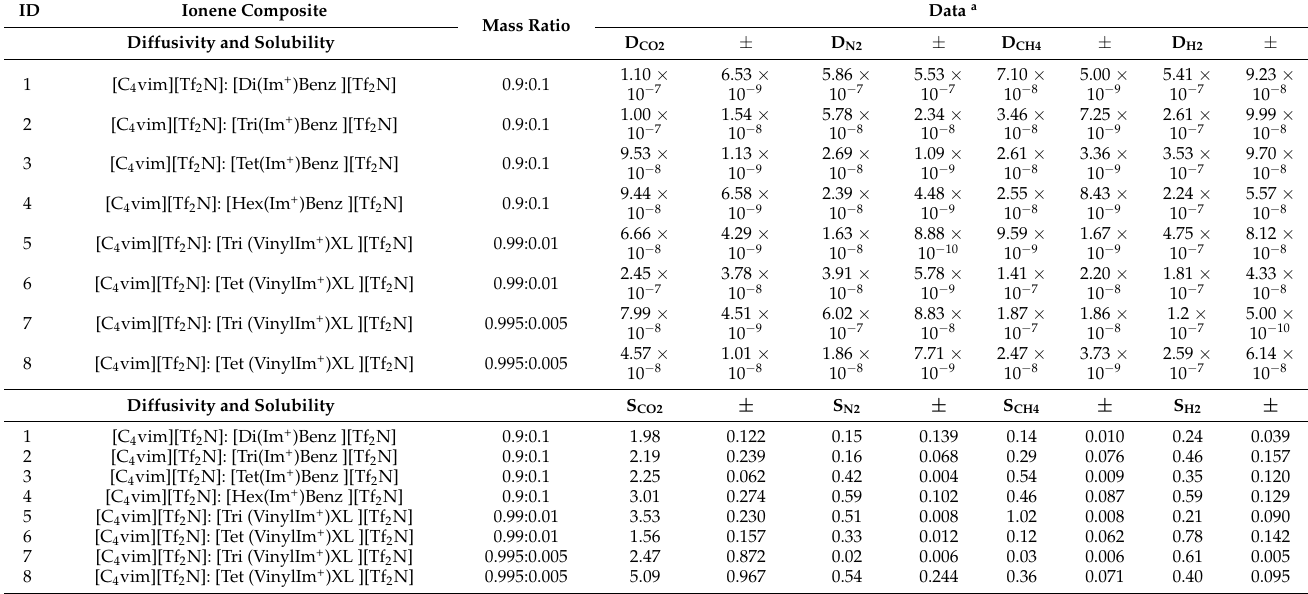
Table 3. Pure gas diffusivity and solubility data for each PIL